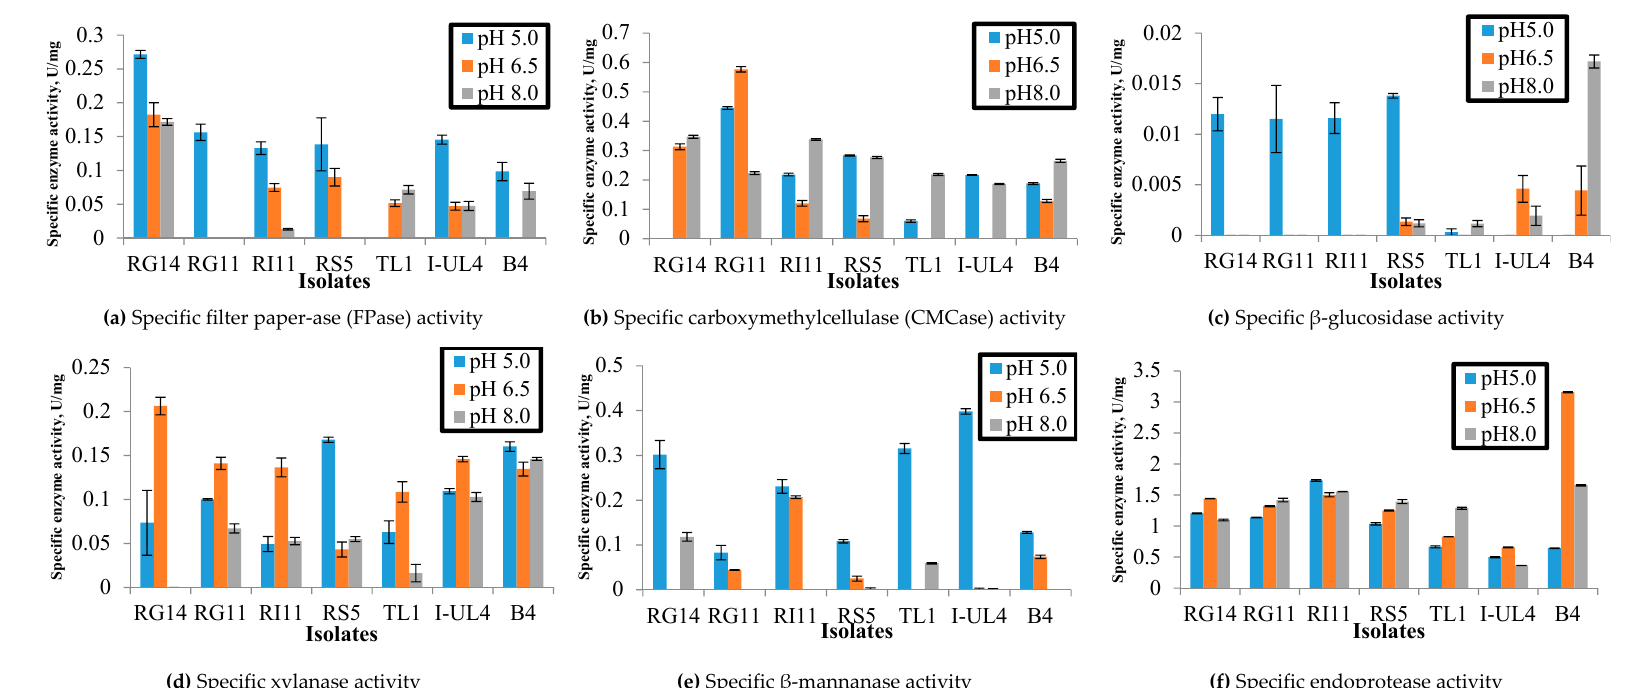
Figure 1. Effect of pH on specific extracellular hydrolytic enzyme activities of Lactobacillus plantarum strains. ( a ) Specific filter paper-ase activity (FPase); ( b ) Specific carboxymethylcellulase activity (CMCase); ( c ) Specific β -glucosidase activity; ( d ) Specific xylanase activity; ( e ) Specific β -mannanase activity; ( f ) Specific